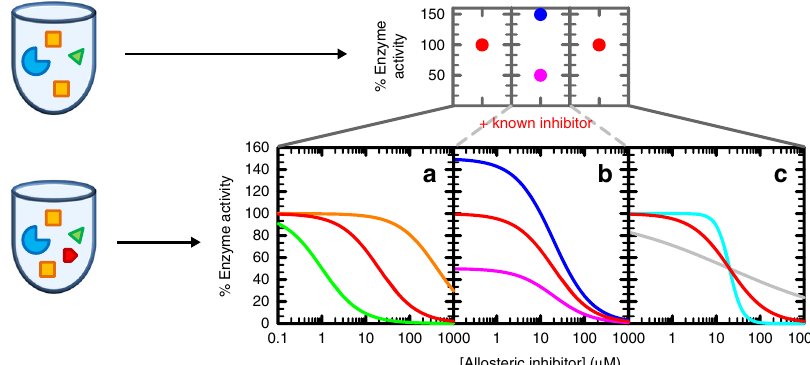
Fig. 1 Schematic representation of CoSPI method vs conventional screenings. In the Compound Screening in the Presence of an Inhibitor (CoSPI) strategy, complete IC 50 curves are recorded for a known inhibitor in the presence of each of the test compounds. The enzyme is in blue , substrates in yellow , known inhibitor in red and compound to test in green . The top panels show the single points observed in a conventional screening ( red dots are missed hits, blue is an activator and pink an inhibitor). The bottom panels show the information-rich patterns observed using CoSPI. Curves depict simulated data for an inhibitor with IC 50 = 20 µ M, Hill number of 1 and capable of full inhibition (100 to 0% activity). The red curve are the data for the known inhibitor in the absence of other molecules. a Effects in the potency of the inhibitor. Green , increase in the apparent af fi nity of the inhibitor. Orange , decrease in the apparent af fi nity of the inhibitor. b Effects in the activity of the enzyme independently of the inhibitor. Blue , increase in the activity of the enzyme. Pink , decrease in the activity of the enzyme. c Effects in inhibitor-enzyme cooperativity. Cyan , increase in the cooperativity of inhibition. Grey ,